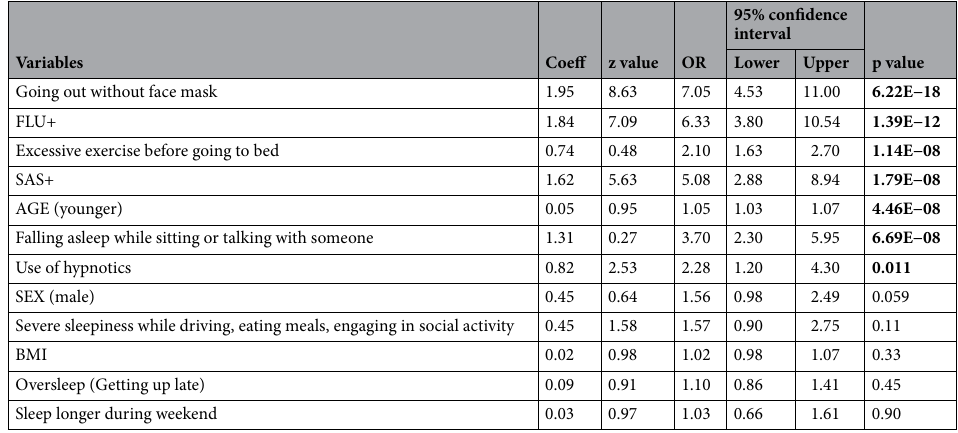
Table 6. Odd ratio and 95% confidence interval for the significant association of the variables with COVID- 19+, all age. Significant values are in bold.